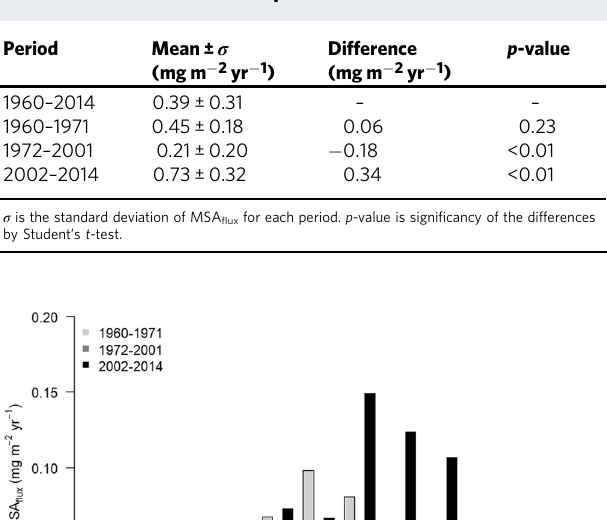
Table 1 Mean annual MSA fl ux for each period and their differences from the entire period.